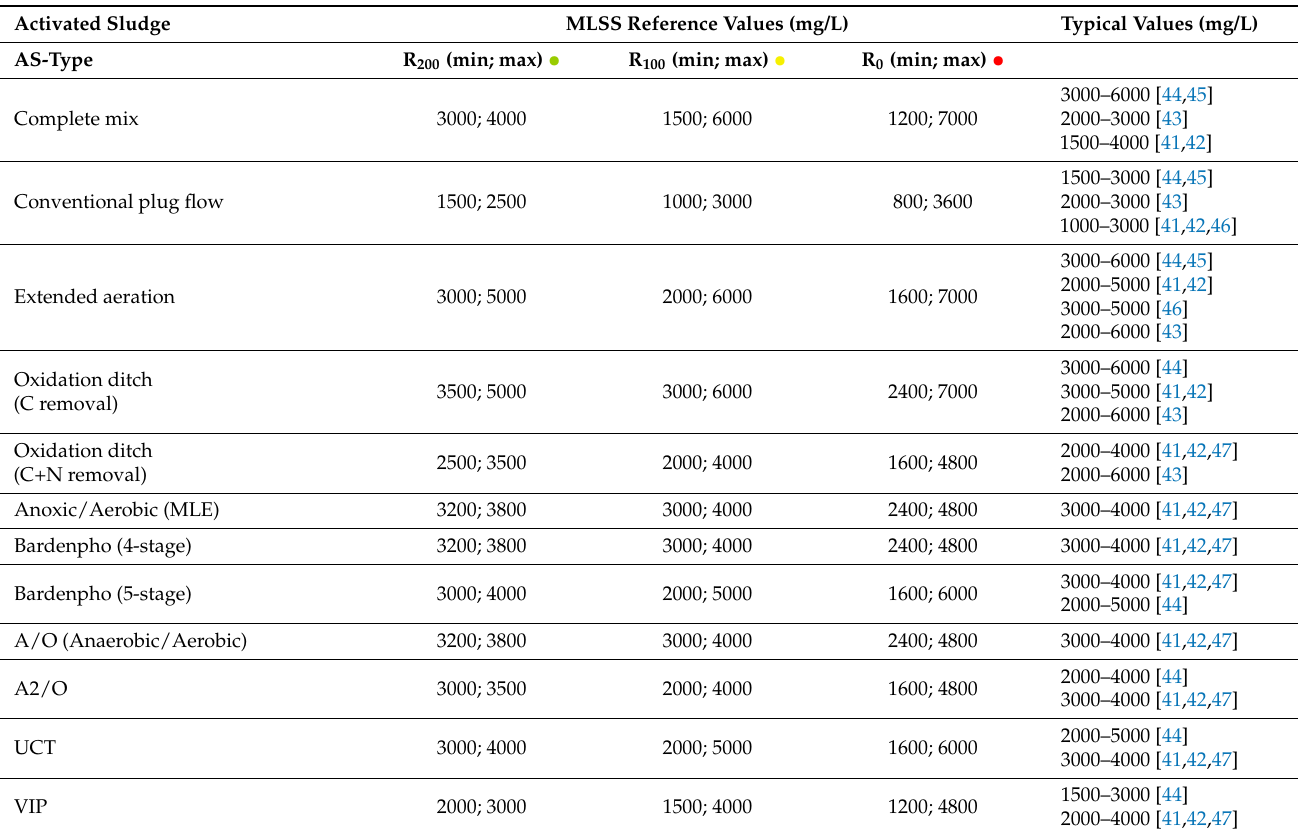
Table 3. The reference values for MLSS in AS systems.